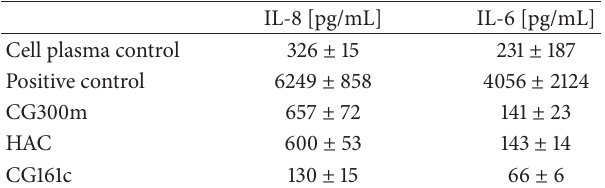
Table 4: IL-6 and IL-8 secretion by HUVECs. Mean IL-6 and IL- 8 secretion ± standard deviation ( 𝑛 = 3 ) of HUVECs after a 16- hour treatment with cell media containing 10% of plasma from the different adsorption studies in the dynamic model. Untreated plasma from LPS stimulated blood acts as positive control and cell plasma control denotes plasma from blood without LPS